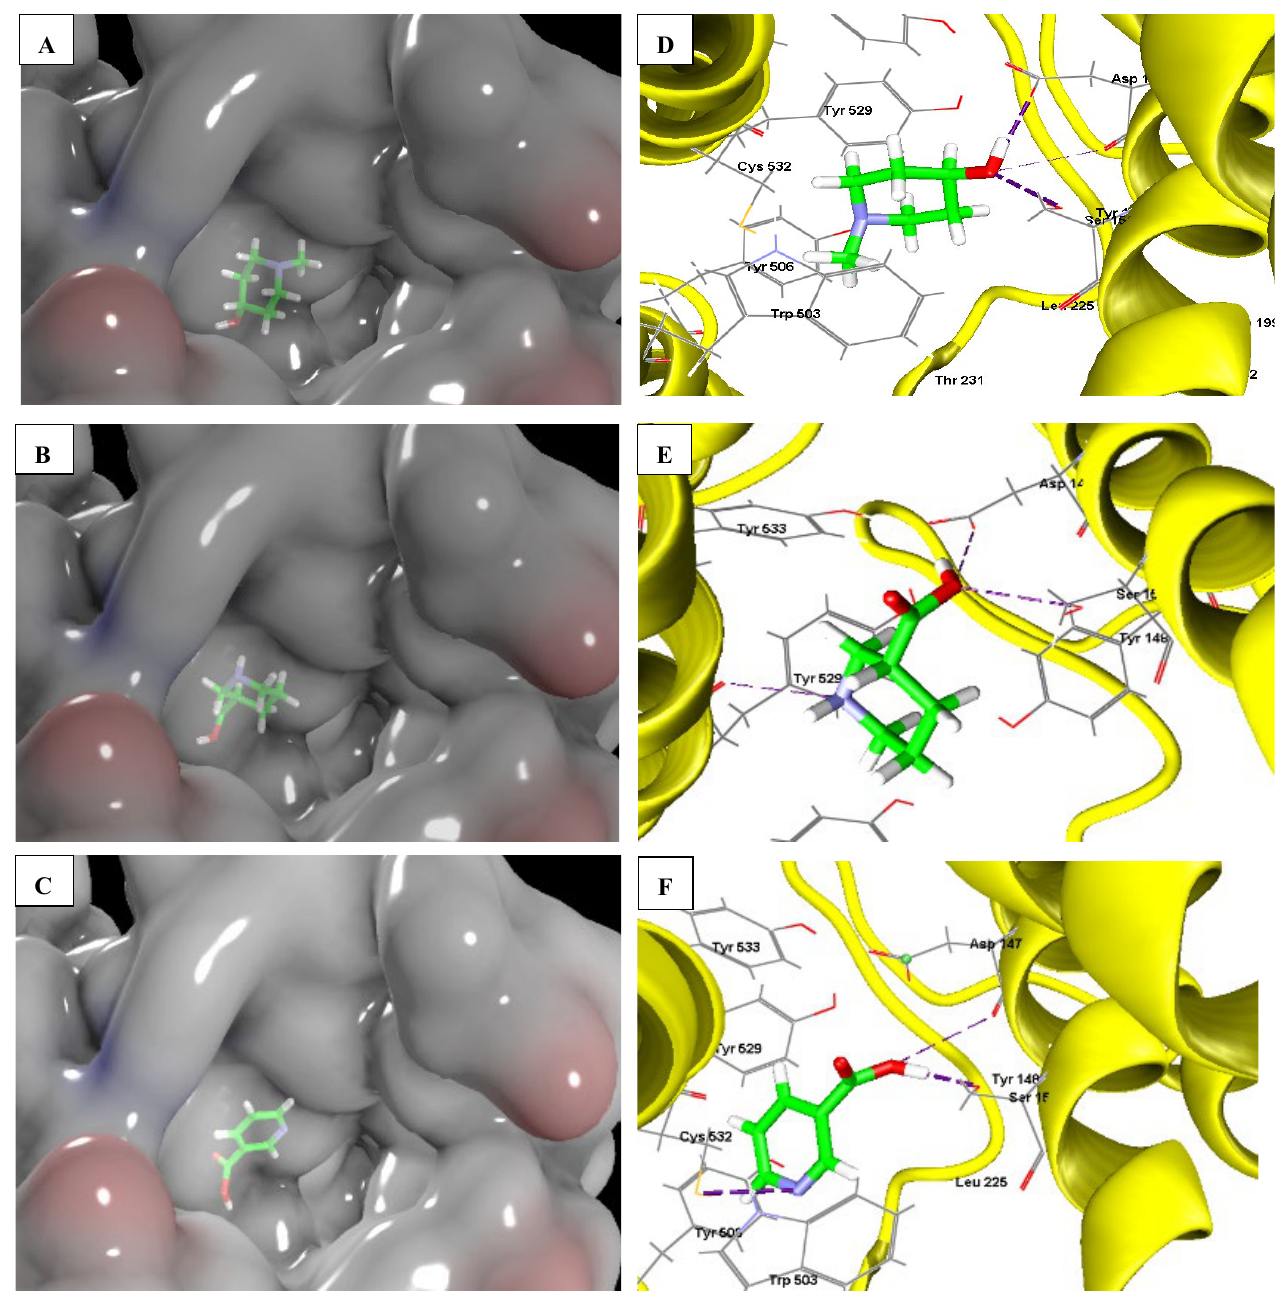
Figure 6. The binding mode of compounds 1, 3, and 5 . Electrostatic surface representation of ligand binding pocket of compounds 1 ( A ), 3 ( B ), and 5 ( C ). Amino acid residues involved in ligand interaction and hydrogen bonds are shown as blue dashed lines, 1 ( D ), 3 ( E ), and 5 ( F ).